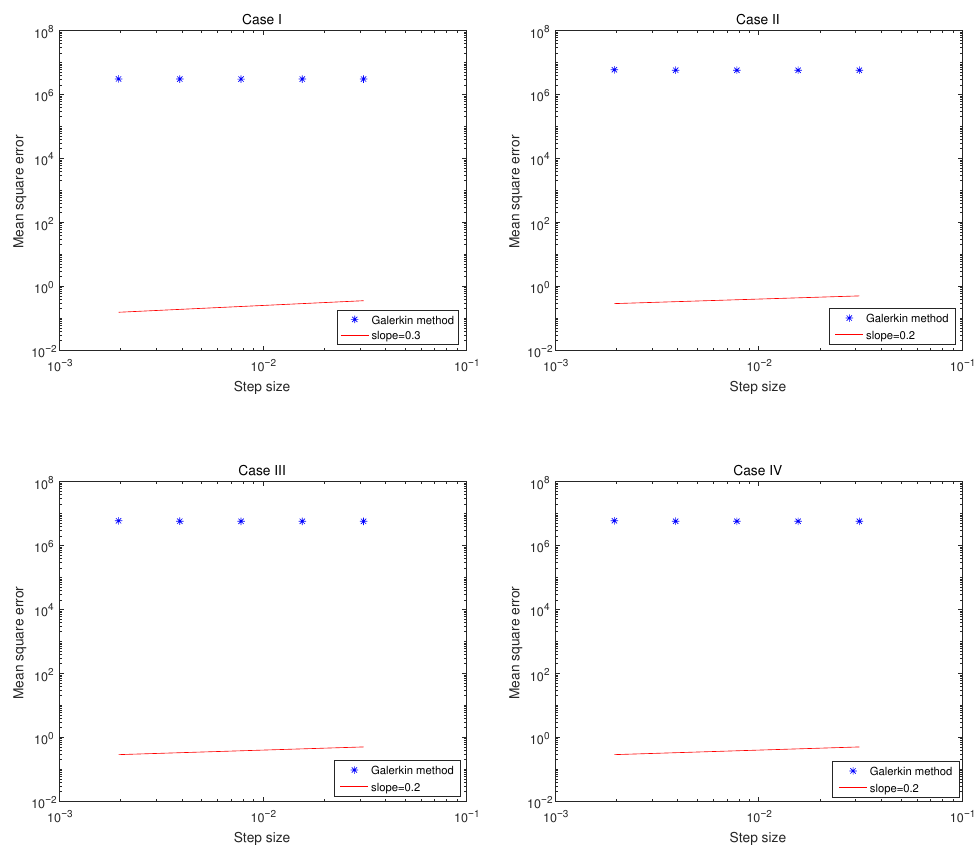
Figure 1. Loglog plot of errors against step sizes for the four cases.